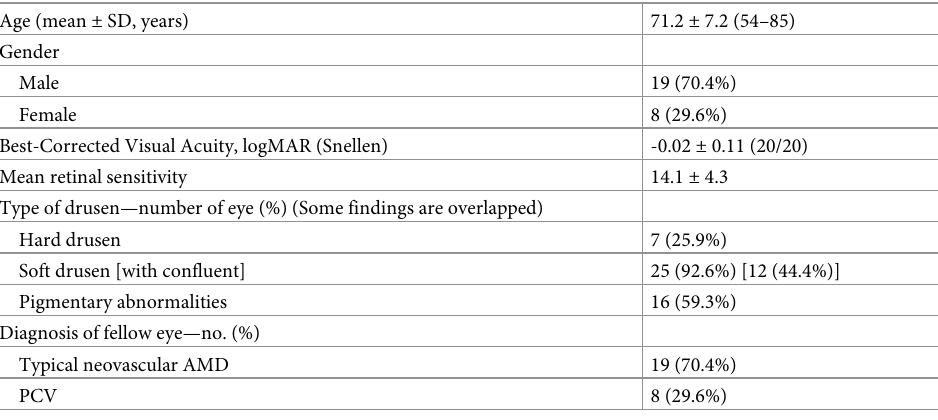
Table 2. Baseline profiles of study patients (n = 27).